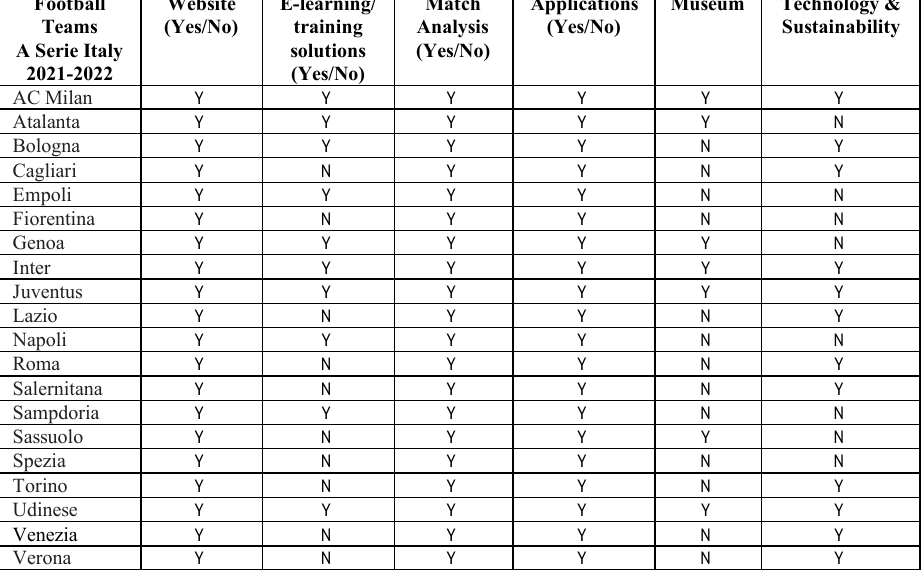
Table 1: A brief portrait of the Italian Serie A Championship in the 2021/2022 season. Football